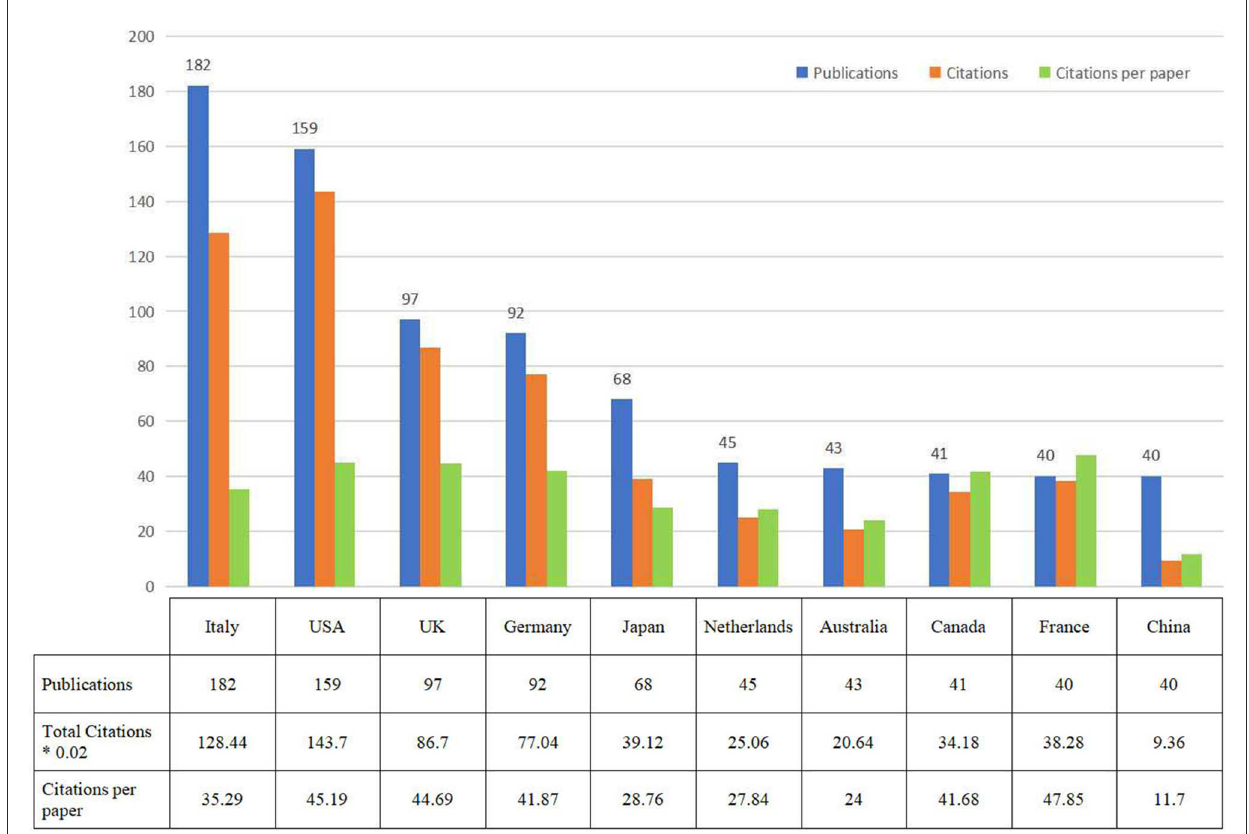
FIGURE3 The number of publications, total citations, and citations per paper in top 10 countries.